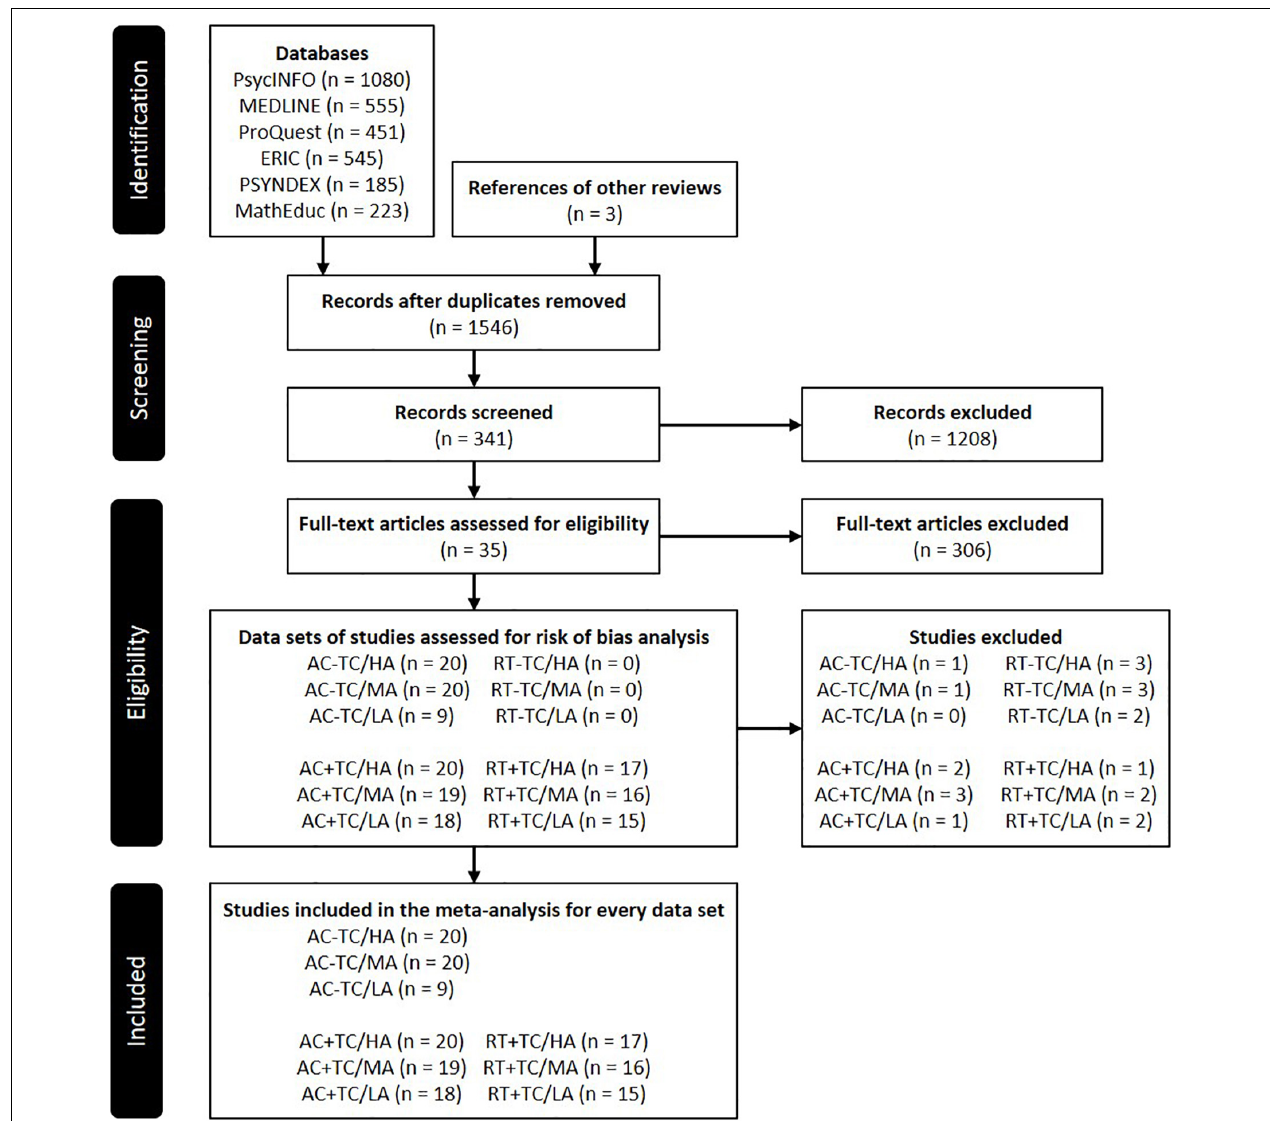
FIGURE 1 | Flow chart of literature search. AC, accuracy; RT, response time; TC, time constraints; HA, high-level ability; MA, medium-level ability; LA, low-level